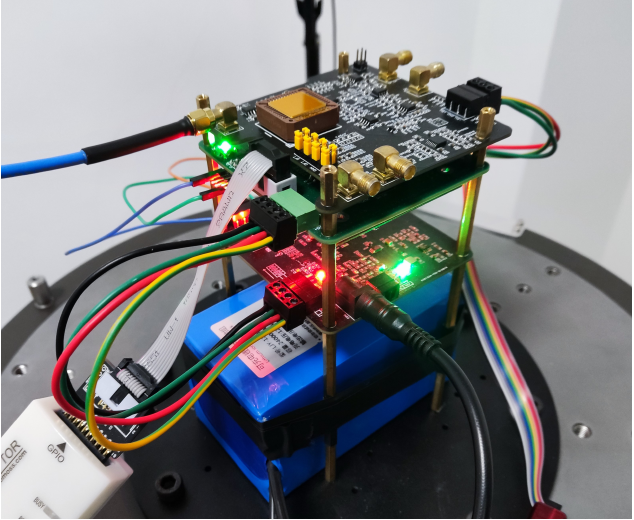
Figure 6. Gyro circuit prototype with hybrid interface